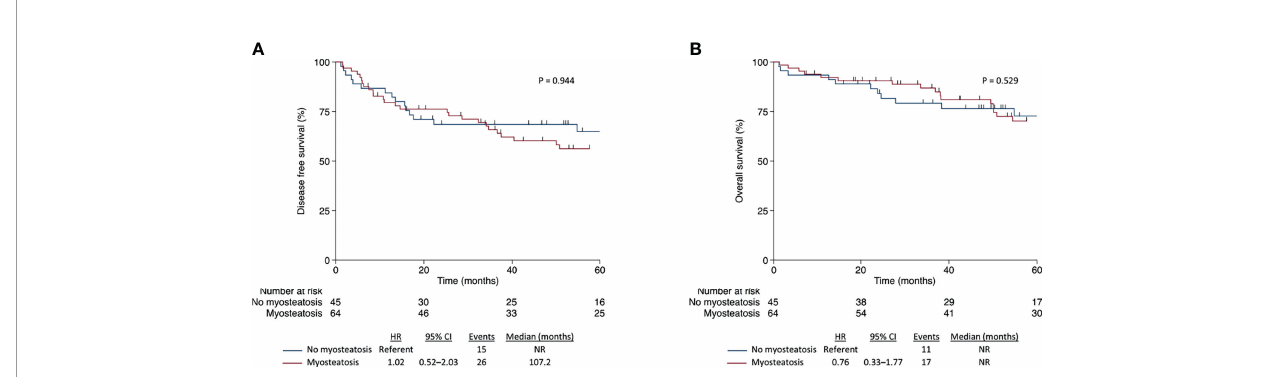
FIGURE 3 | Disease-free survival (A) and overall survival (B) according to myosteatosis in patients with rectal cancer.